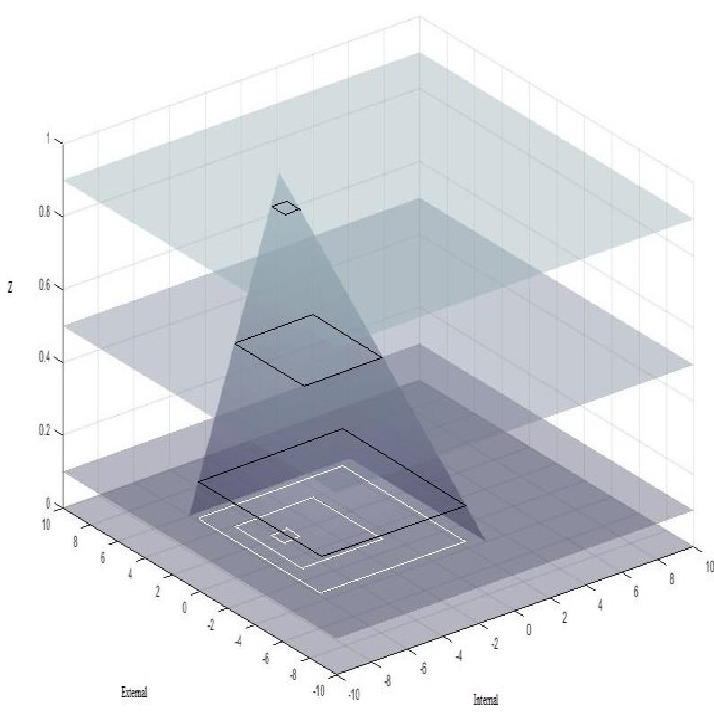
Figure 12. Three α -cut plane cut pyramid.